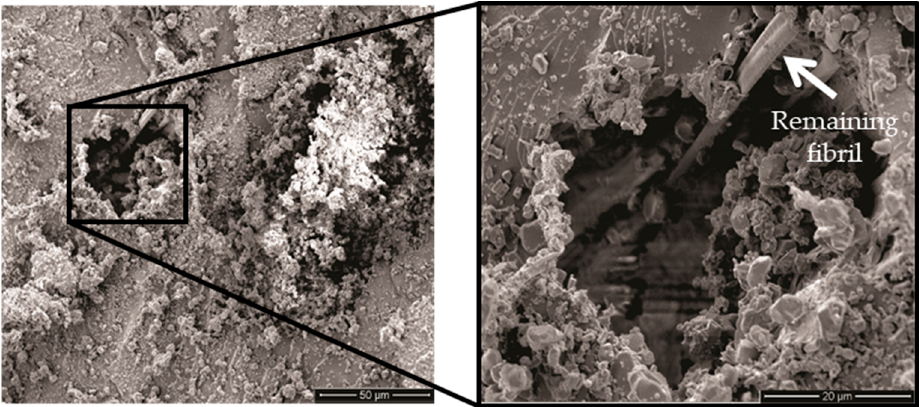
Figure 17. Fiber pullout of the CF composites .